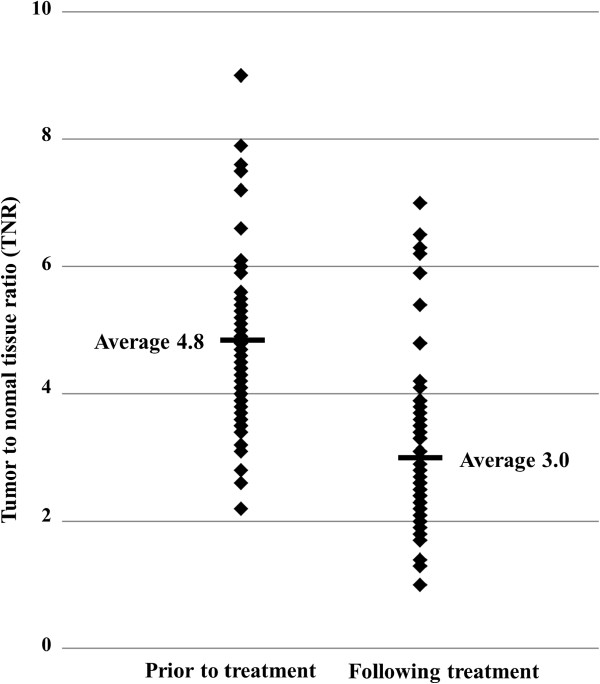
A comparison of the tumor to normal tissue ratio (TNR) prior to and following CIRT. The average values of the TNR prior to treatment and after treatment were 4.8 ± 1.5 (2.6-9.0) and 3.0 ± 1.3 (1.0-7.0), respectively, and the difference between them was significant (paired-t test, p < 0.0001).